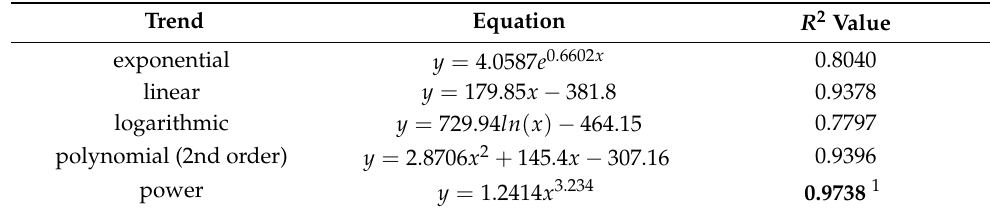
Table 1. Equations of trendlines for the Scopus dataset corresponding to the expression “big data analytics” (for the years